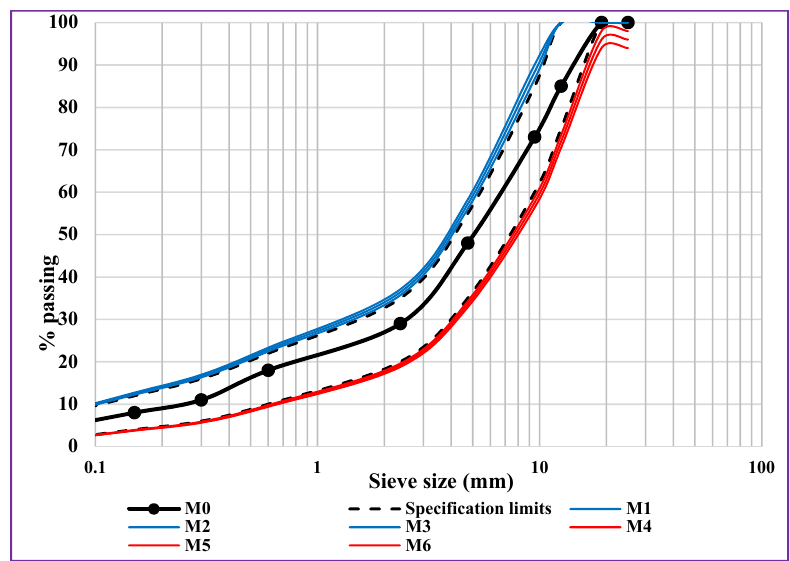
Figure 6. Different gradations for 3B mix.